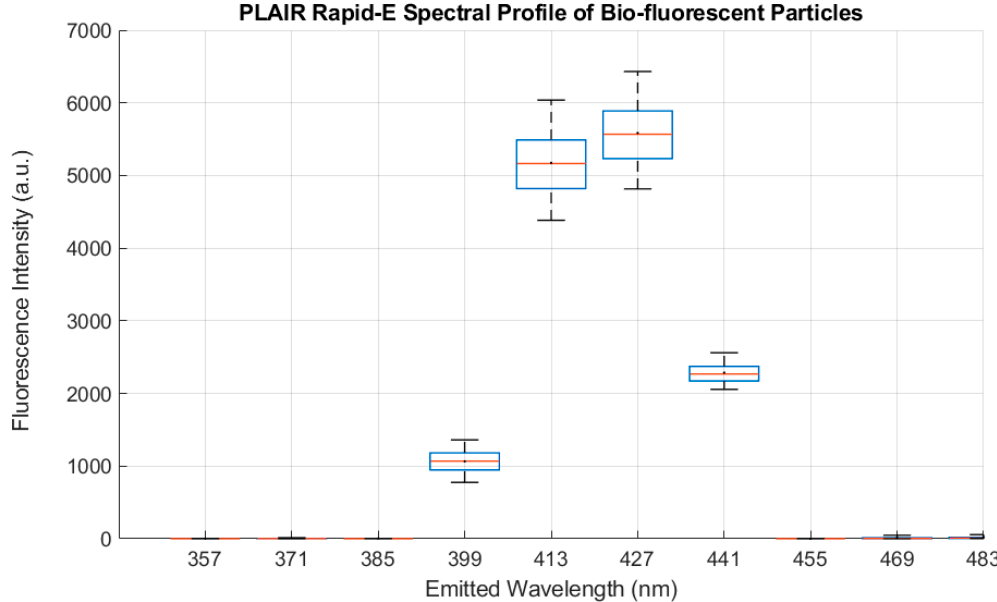
Figure 4. Fluorescence intensity recorded across the PLAIR Rapid-E’s first 10 detection channels for all biofluorescent particles. The x -axis shows the peak wavelength (nm) associated with each channel, with the width of each box reflecting the 14 nm range of the associated channel. Each red line represents the median value with the mean denoted by a dot. Whiskers represent 5th and 95th percentile values.